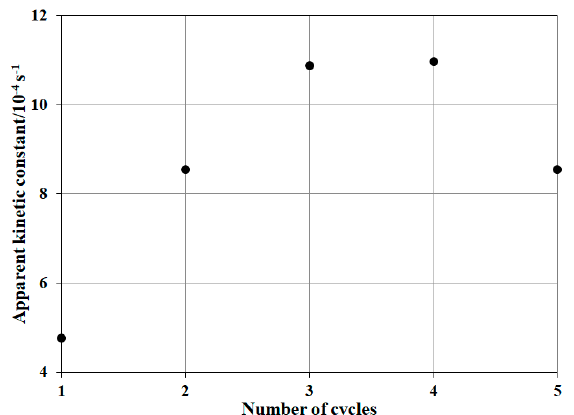
Figure 13. The effect of the reuse of the NP-3 catalyst on the relative efficiency the MB degradation. Concentrations: NP-3 = 400 mg/L, conc. of MB = 1.5 × 10 − 5 mol/L, pH = 7.5, and conc. of H 2 O 2 = 1.76 × 10 − 1 mol/L.